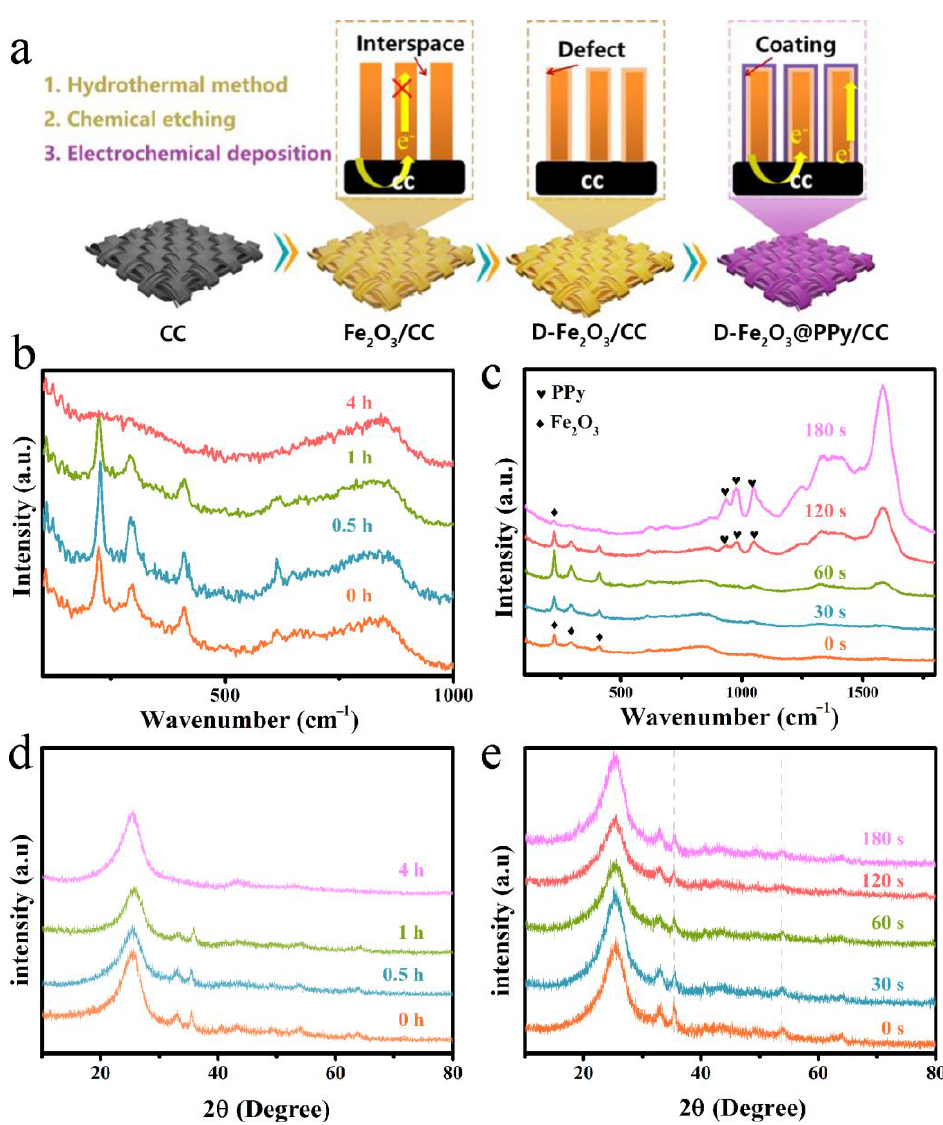
Figure 1. (a) Schematic illustration of the fabrication process of a D-Fe 2 O 3 @PPy/CC electrode. Raman spectra of ( b ) D-Fe 2 O 3 -xh (x = 0.5, 1, and 4) and ( c ) D-Fe 2 O 3 @PPy-ys (y = 30, 60, 120, and 180) electrodes. The corresponding XRD patterns of ( d ) D-Fe 2 O 3 -xh and ( e ) D-Fe 2 O 3 @PPy-ys electrodes. The surface chemistry of Fe 2 O 3 /CC, D-Fe 2 O 3 /CC, and D-Fe 2 O 3 @PPy/CC were investi-